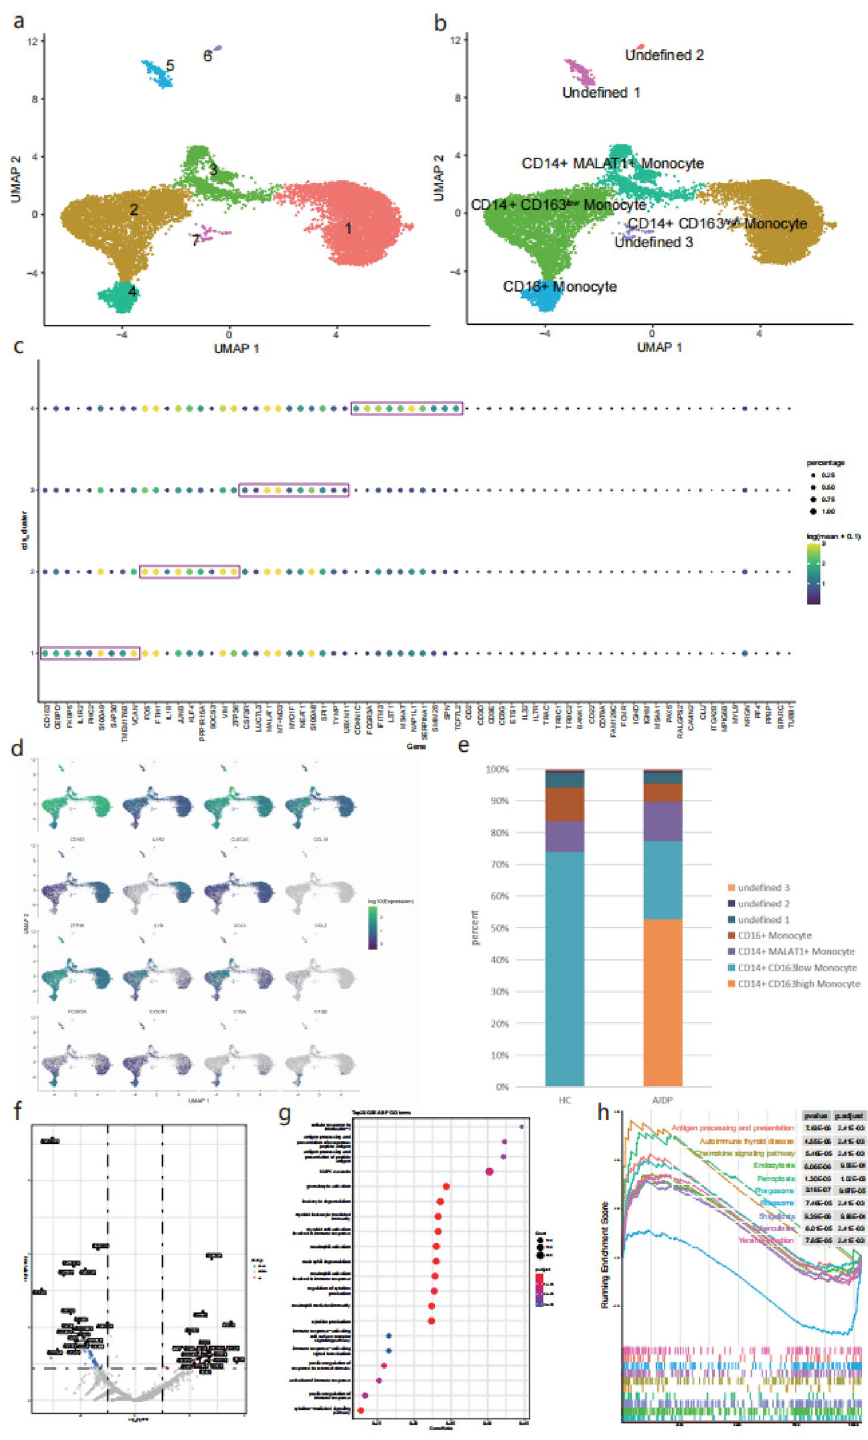
Figure 5. Landscape of monocytes and characteristics of AIDP specific subtype. ( a ) UMAP visualization of cell clusters after re-clustering monocytes. ( b ) UMAP visualization of manually annotated cell types of monocytes. ( c ) A dot plot of top 10 most differentially expressed genes for identified monocyte clusters, the dots of top 10 genes are circled by purple boxes in monocytes clusters. Some genes are overlapped across clusters. Color scale of dots represents the gene expression levels in each cluster, size of dots represents the percentage of cells expressing a gene in each cluster. ( d ) Distribution of some representative marker genes in monocytes. Color scale represents the gene expression levels in each cell. ( e ) Proportion of cell types in each group. The colors indicate cell type information. ( f ) Volcanos of top 20 upregulated and downregulated DEGs between HC and AIDP patients of CD14 + CD163 high monocyte. ( g ) GSEA-GO enrichment analysis in DEGs of CD14 + CD163 high monocyte. Dot plots display top 20 biological process of GO terms according to P value. ( h ) GSEA-KEGG enrichment analysis in DEGs of CD14 + CD163 high monocyte. GSEA enrichment plots display top 10 KEGG pathways according to P